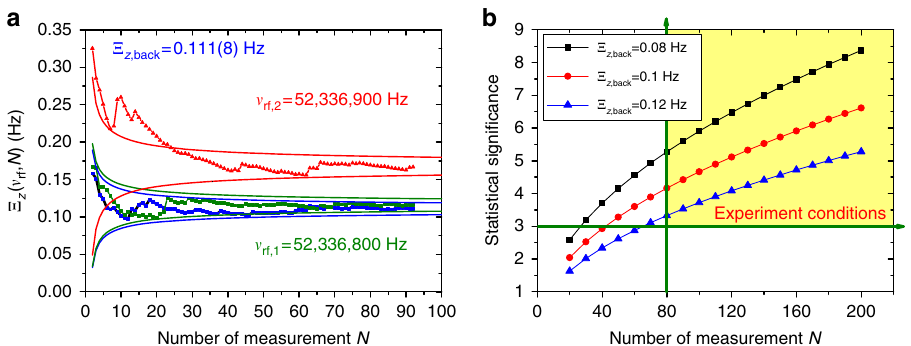
Figure 3 | Measurement of the Larmor frequency. ( a ) Cumulative measured axial frequency fluctuation X z ( n rf ) for a background measurement and two different spin-flip drive frequencies at n rf,1 ¼ 52,336,800Hz and n rf,2 ¼ 52,336,900Hz. The blue data points reflect the background measurement, the green and the red points display X z ( n rf,1 ) and X z ( n rf,2 ), respectively. The solid lines indicate the 68% confidence intervals of the measurements. ( b ) Statistical significance ( X z ( n rf ) (cid:2) X z ,back )/( s ( DX z ( n rf ), DX z ,back ) for three different background fluctuations X z ,back and as a function of the number of accumulated measurements. For all frequency determinations which contribute to the g -factor evaluation the experiment was operated under the conditions highlighted by the yellow background, where ( X z ( n rf ) (cid:2) X z ,back ) 4 3 s ( DX z ( n rf ), DX z ,back ). Figure 3a shows results of such a measurement. The blue data-points represent the cumulative axial frequency background fluctuation X z ,back . The green data points display X z ( N , n rf,1 ), measured while an rf-drive at n rf,1 ¼ 52,336,800 Hz was applied. The red data points show X z ( N , n rf,2 ) where the rf-drive was tuned to n rf,2 ¼ 52,336,900 Hz. The solid lines represent the 68% confidence intervals of X z ( N , n rf, k ). From the measurement shown in Fig. 3a we extract after accumulation of N ¼ 93 data points X z ,back ¼ 0.111(8) Hz, X z ( n rf,1 ) ¼ 0.116(8) Hz and X